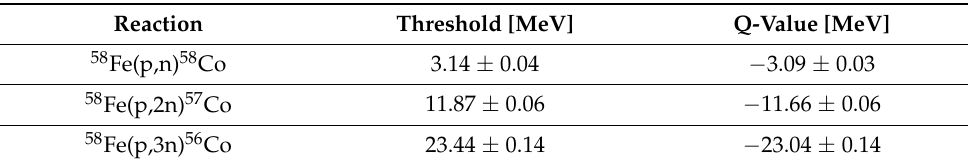
Table 1. Nuclear reactions, thresholds, and Q-values for the production of Co radioisotopes from 58 Fe